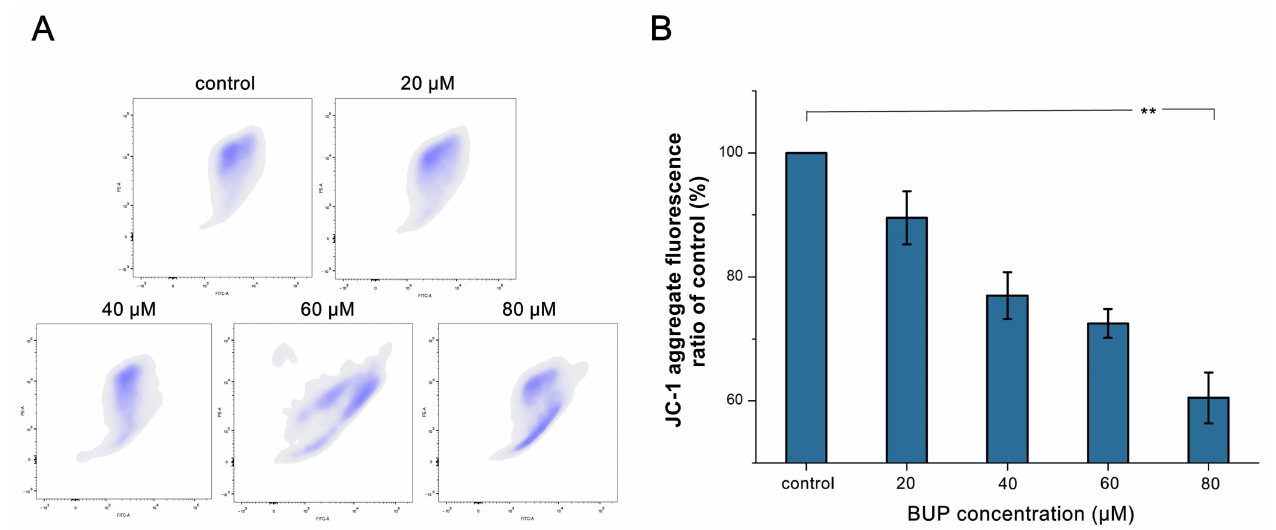
Figure 5. Investigation of MMP decline in A549 cells after exposure to BUP at various concentrations, showing: ( A ) detection of JC-1 dyeing by flow cytometry, ( B ) quantification of MMP decline levels. ** p ≤ 0.01 vs. negative